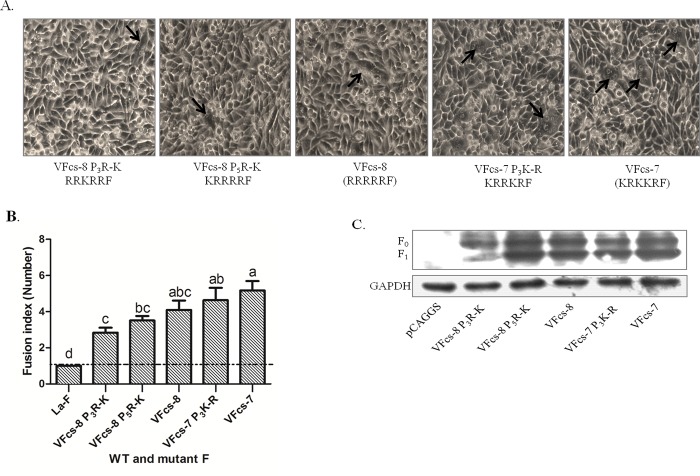
Membrane fusion capacity induced by virulent Fcs with all basic residues.(A) VFcs-7(P3K-R), VFcs-8(P3R-K) and VFcs-8(P5R-K) were transfected into DF1 cells with wild-type HN. Syncytia are indicated by black arrows. (B) Average syncytia size was determined. Results are the average of three different experiments where statistical significance is designated with lowercase letters and different letters indicate significant differences (P<0.05). (C) Proteolytic cleavage of F protein mutants co-transfected with wild-type HN in BHK-21 cells, as analyzed via Western blot. GAPDH protein expression is shown as a control. Proteins were detected by Western analysis with anti-Flag antibody. F0, uncleaved fusion protein; F1, cleaved F0 product.